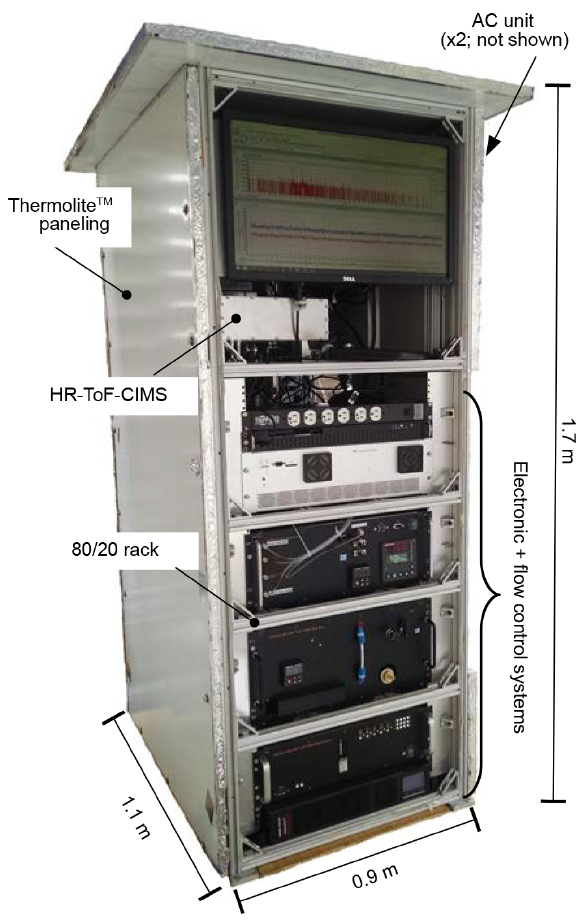
Figure 4. The weatherproofed and temperature-controlled enclo- sure in which the instrument resides during field sampling. The front panel of the enclosure is removed in this